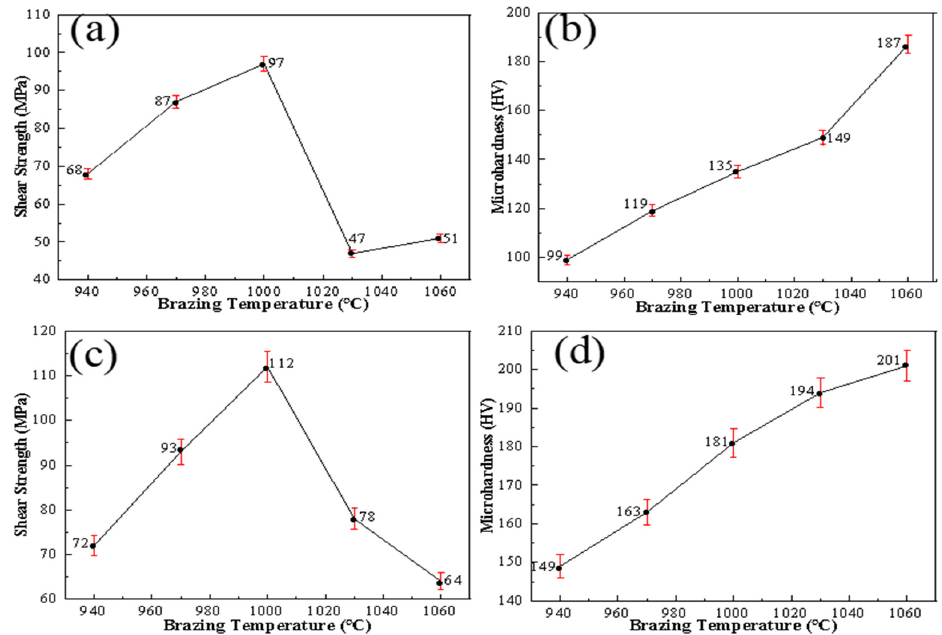
Figure 13. Mechanical properties and microhardness of joints under different welding temperatures: ( a , b ) Ti/Cu/Ti shear strength and interlayer microhardness; ( c , d ) Ti/Cu/Kovar/Cu/Ti shear strength and interlayer microhardness.